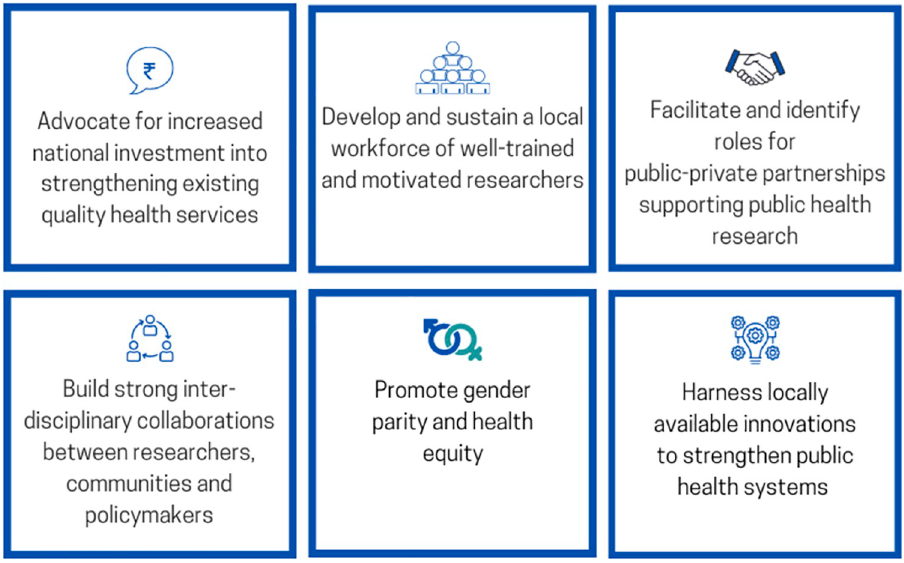
Fig 2. Recommendations for establishing research priorities in maternal and child health. Legend: General recommendations for establishing research priorities in maternal and child health in India. These recommendations have been informed by the results of this study, and our engagement with key stakeholders, and are in alignment with the World Health Organization’s report on research for universal health coverage † . † World Health Organization. Research for universal health coverage: World health report 2013. Available at https://www.who.int/publications/i/